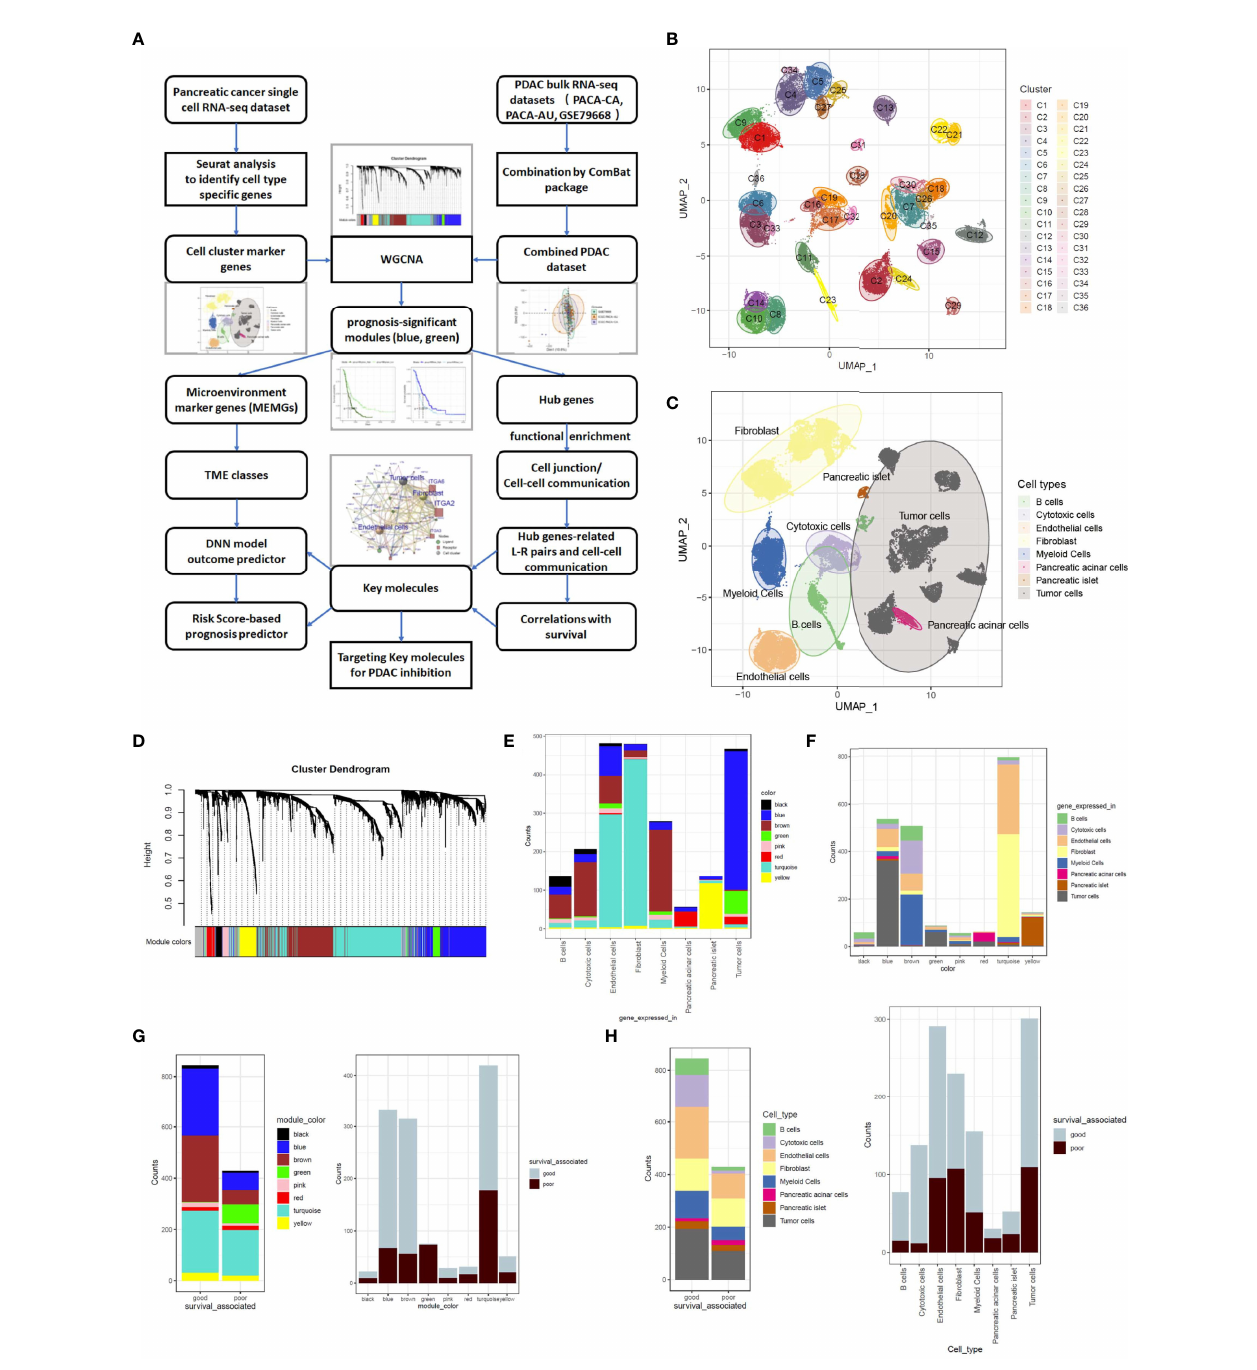
FIGURE 1 | Weighted gene coexpression network analysis (WGCNA) classi fi es cell component marker genes into eight gene modules in pancreatic cancer. (A) The work fl ow diagram summarizes the study design in this work. (B, C) Uniform Manifold Approximation and Projection (UMAP) visualization of pancreatic ductal adenocarcinoma (PDAC) single-cell sequencing data exhibits the cell clusters discovered by Seurat analysis (B) and the cellular identity of each cluster (C) . The cell type of each cluster was distinguished through the expression of well-documented markers (shown in Supplementary Figure 1A ) and grouped into eight major components. (D) Cell component marker genes found in PDAC single-cell dataset were subjected to WGCNA in a combined PDAC bulk RNA-sequencing dataset. In this process, eight gene- network modules were detected. (E) Stacked barplots show the cell origins of the genes constituting each module. (F) Distribution of different cell component marker genes in the gene modules. (G, H) Barplots show the prognostic signi fi cant genes in every gene module (G) and each cell type (H) . The prognosis signi fi cance was determined by Cox regression